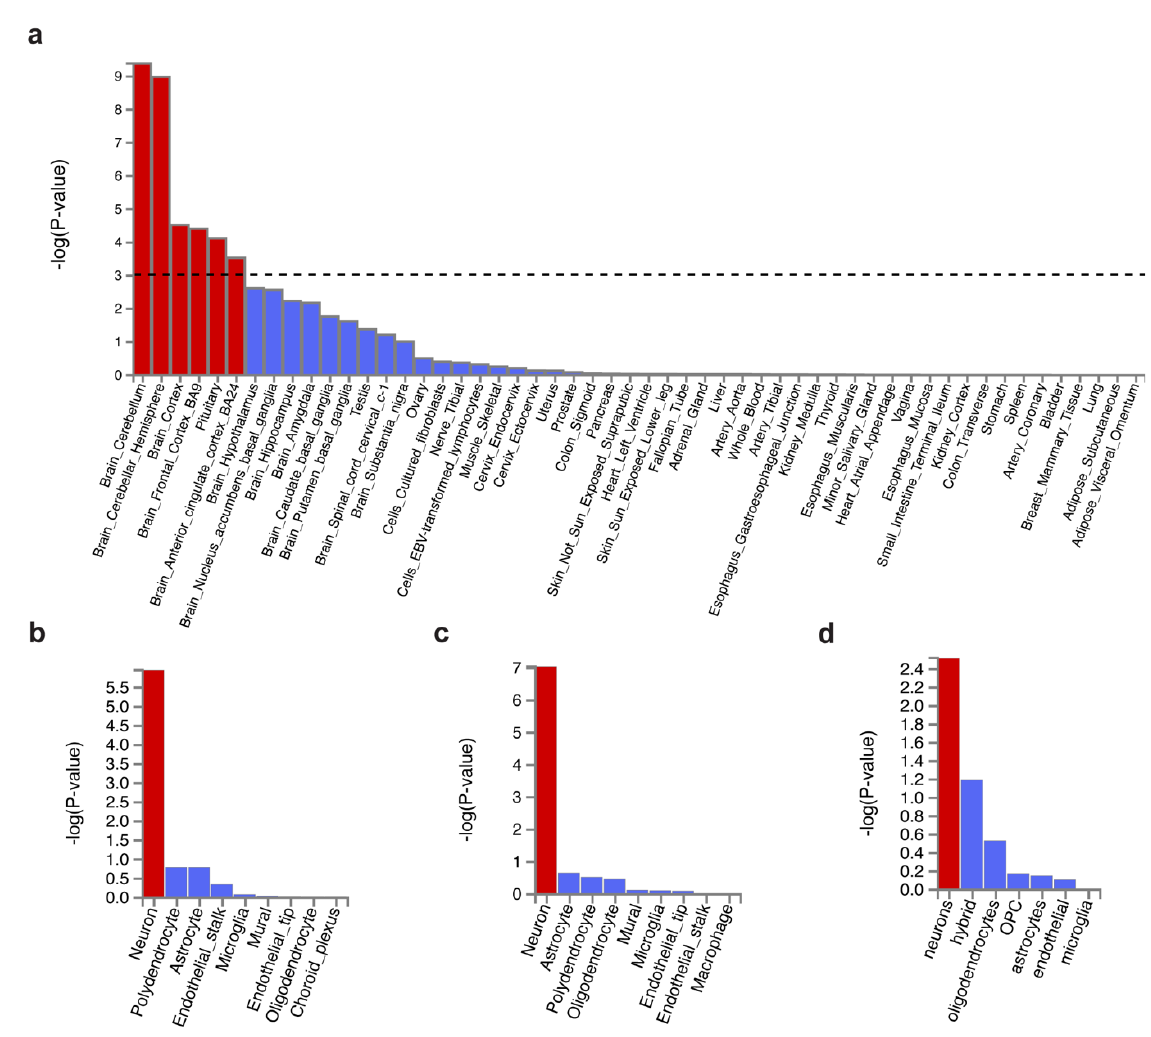
Figure 2. Tissue expression and cell type specificity enrichment of genes associated with shared genetic variants. ( a ) Tissue expression enrichment in GTEx 54 tissue types. The dashed line indicates the significance threshold at p = 0.001. ( b )–( d ) Cell type specificity in ( b ) cerebellum, ( c ) frontal cortex BA9, and ( d ) BA24. Bars in red represent significant enrichment.